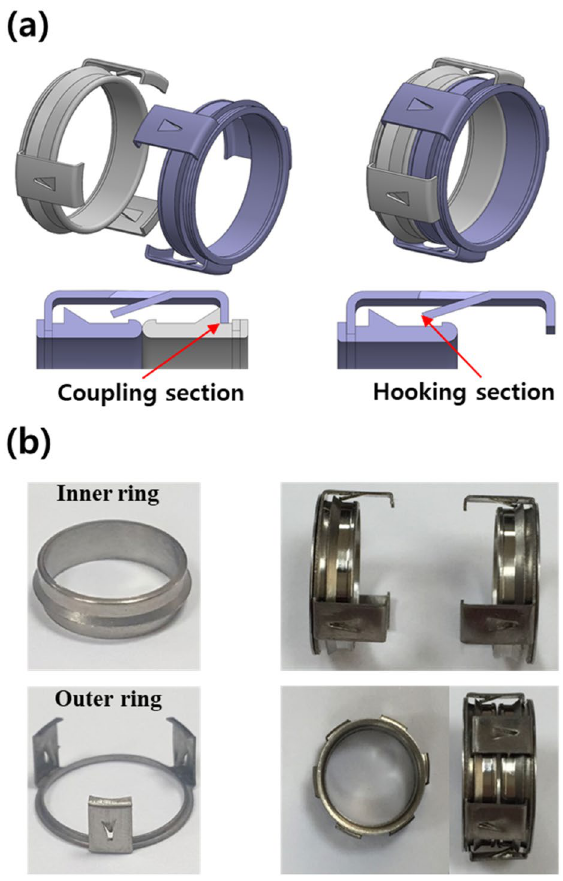
Figure 1. ( a ) Design of the titanium vascular anastomotic device (TVAD). TVAD comprises a hooking part that secures each blood vessel to the device and a coupling part that combines the two parts with a blood vessel. ( b ) Photographs of the actual parts assembled. The device comprises inner and outer rings. The inner ring has a protrusion on the body that connects with the connecting arm of the mating outer ring, and the outer ring comprises three connecting arms, with each arm having a triangular ring that hangs on the blood